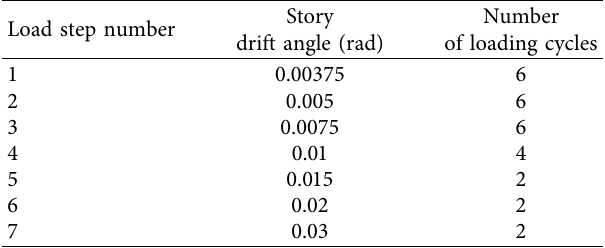
Continue with increments in drift angle of 0.01 and perform two cycles at each step.